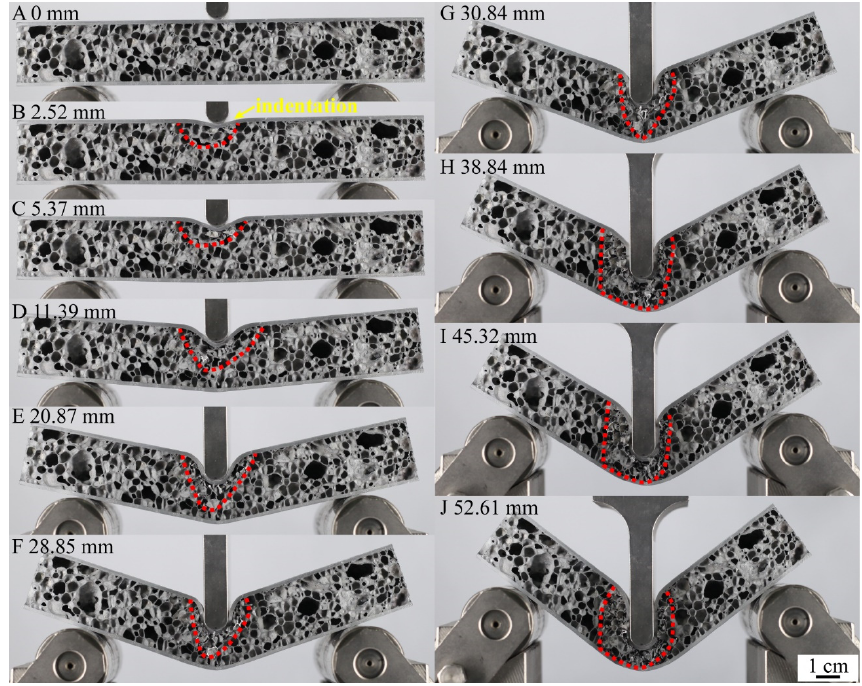
Figure 15. The sequence of images showing the three-point bending experiment of metallurgical bonding AFS.